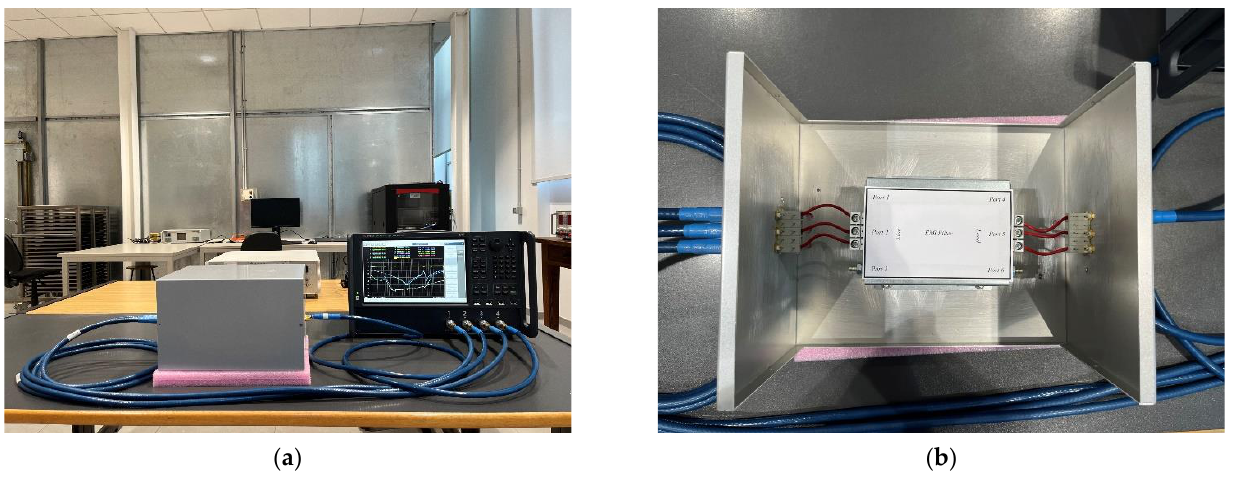
Figure 9. ( a ) Setup for S-parameter measurement of a three-phase filter and ( b ) filter arrangement inside a metallic enclosure equipped with SMA connectors.